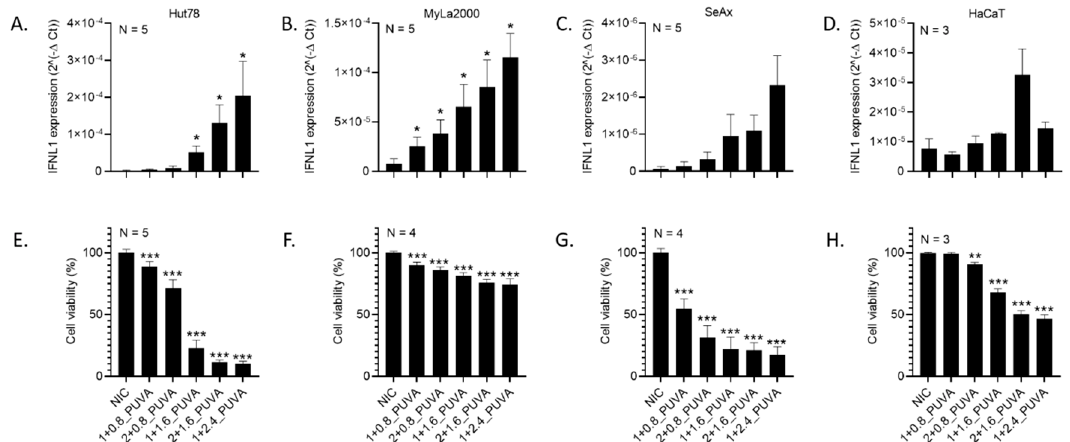
Figure 1. Cutaneous T-cell lymphoma (CTCL)-derived cells express interferon lambda 1 (IFNL1) in response to 8–methoxypsoralen and UVA light (8–MOP + UVA), and its expression is proportional to the cell death. Expression of IFNL1 in ( A ) Hut78, ( B ) MyLa2000, ( C ) SeAx and ( D ) spontaneously immortalized human keratinocytes (HaCaT) treated with increasing doses of 8–MOP + UVA were measured by RT-qPCR and corrected for GAPDH expression. Viability of ( E ) Hut78, ( F ) MyLa2000, ( G ) SeAx and ( H ) HaCaT was evaluated by propidium iodide exclusion assay. Error bars represent ± SEM of the indicated N repeats. * p < 0.1, ** p < 0.05 and *** p < 0.01. NIC—not irradiated control and PUVA—8–MOP + UVA treatment; in the treatment description, the first number refers to the 8–MOP concentration in µM and the second to the UVA dose in J/cm 2 .